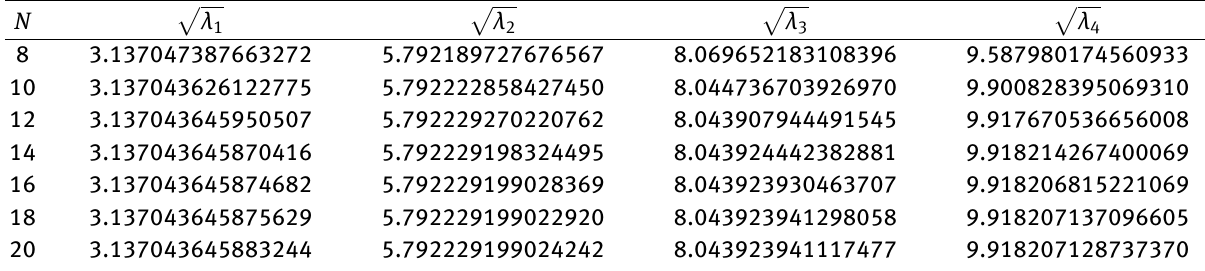
(︁ √ )︁ for SS case for different grid points λ